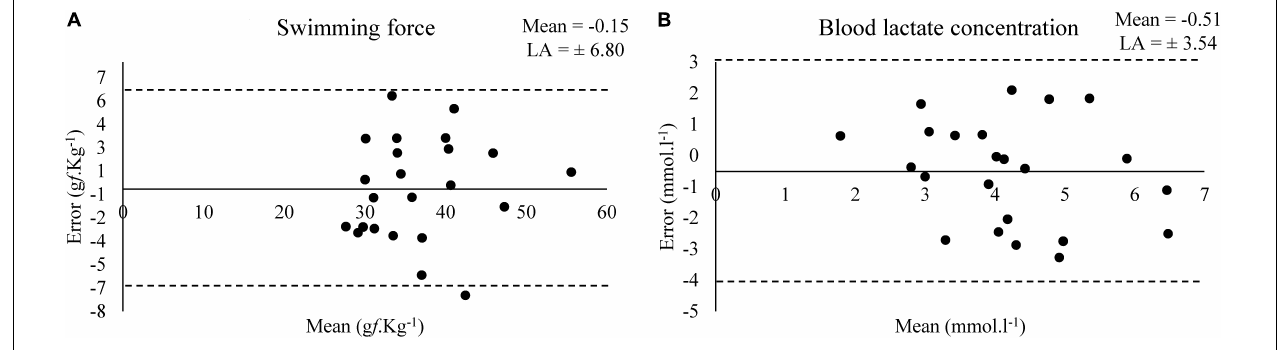
FIGURE 3 | Bland–Altman plots for the values of swimming force (A) and (B) blood lactate concentration in the test and retest at MLSS-intensity ( N = 23).